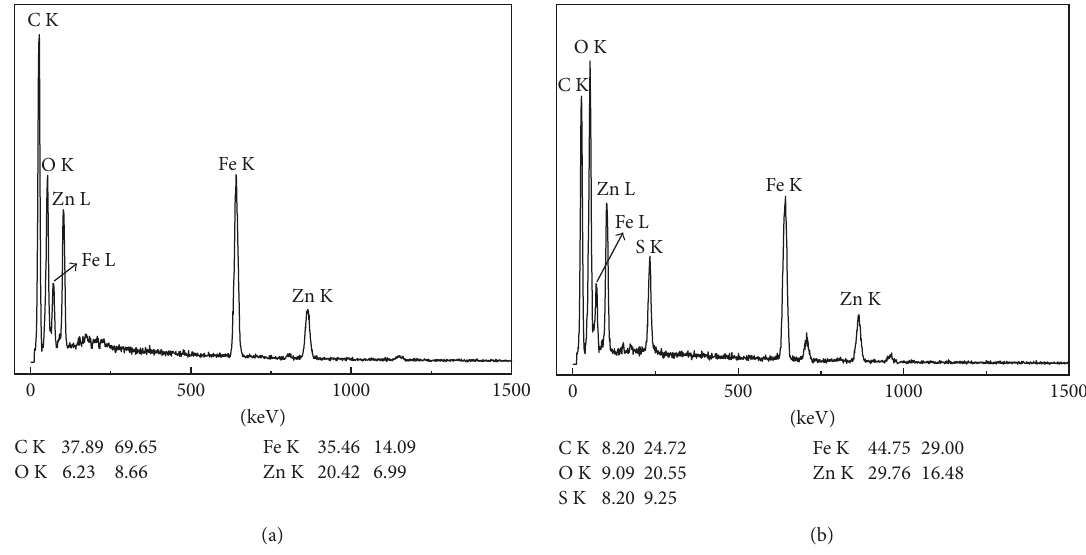
Figure 7: EDS pattern spectra of the SEM image of ZnFe